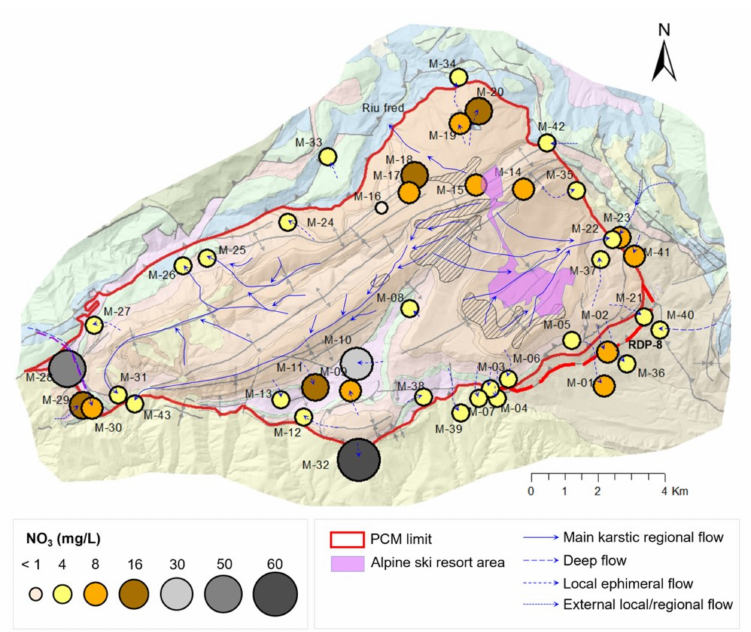
Figure 11. Map of nitrate dissolved in GW. The values correspond to the averaged concentration obtained for all the GW sampling campaigns conducted during the period September 2013–October